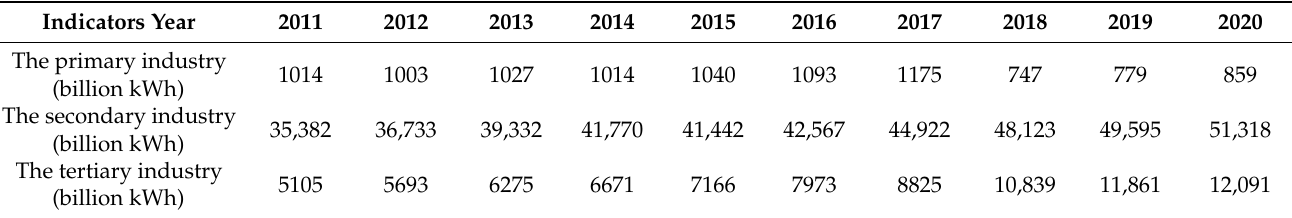
Table 1. China’s industrial electricity usage from 2011 to